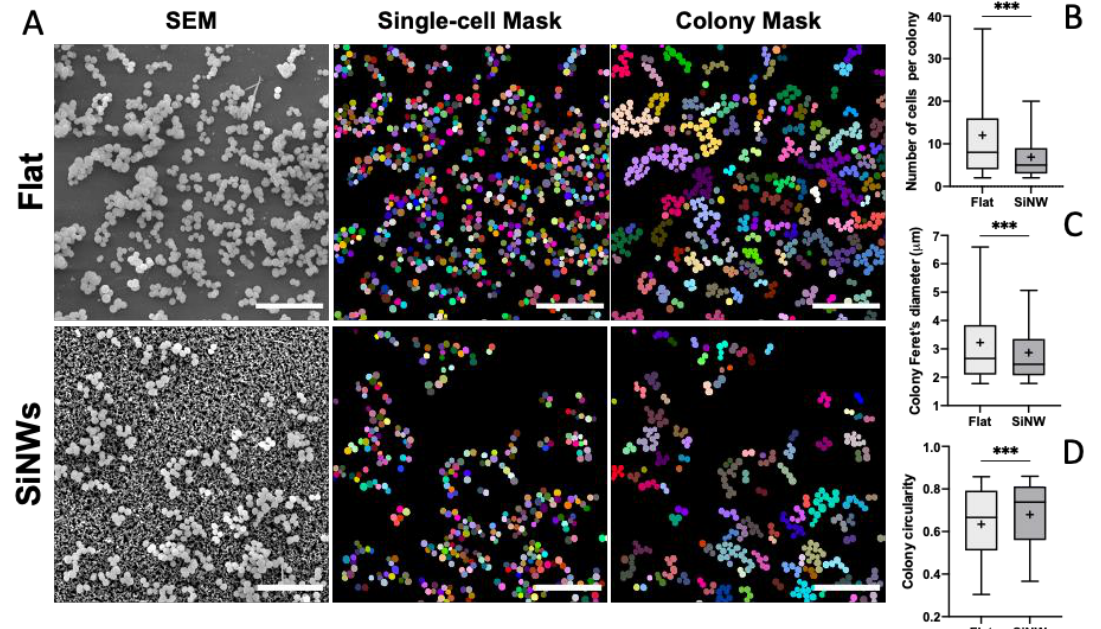
Figure 8. Morphological characterisation of S. aureus micro-colonies on flat Si and SiNW surfaces: ( A ) Top view SEM images, individual cell mask and single colony mask for image segmentation (Scale bars 10µm); ( B ) Weighted number of cells per colony; ( C ) Feret’s diameter for the colonies (in µm); ( D ) Colony circularities on flat Si and SiNW surfaces with error bars showing the standard error of the mean. *** indicates high statistically significant difference between groups ( p < 0.001). Boxplots represent the median (horizontal line), mean (+), interquartile range (box), bottom 5% value (lower whisker) and 95% top value (upper whisker).